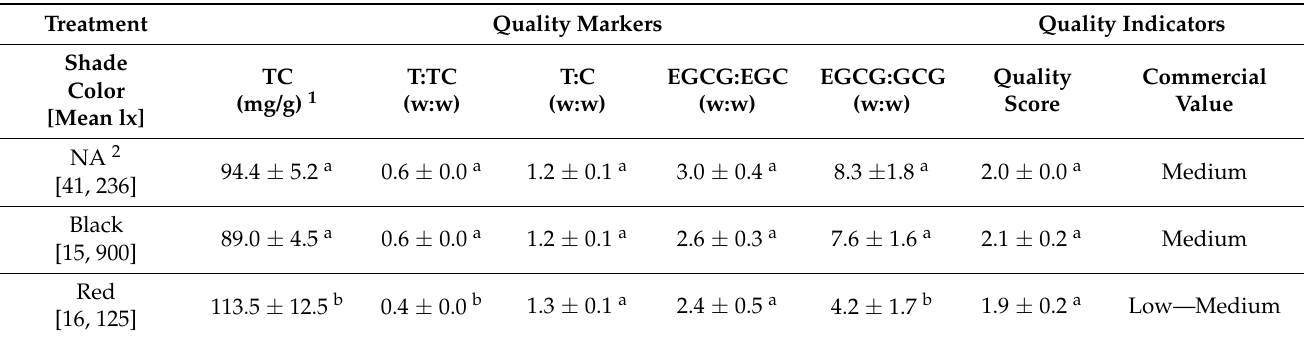
Table 3. Quality markers and quality indicators of green tea plants grown with and without red- colored wavelengths compared to full ambient light conditions.